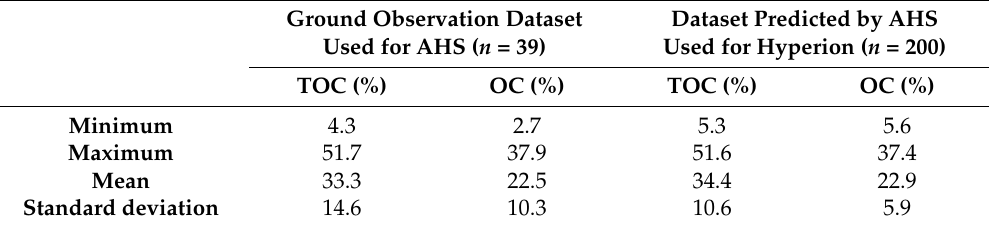
Table 1. Descriptive statistics of soil organic carbon (SOC).